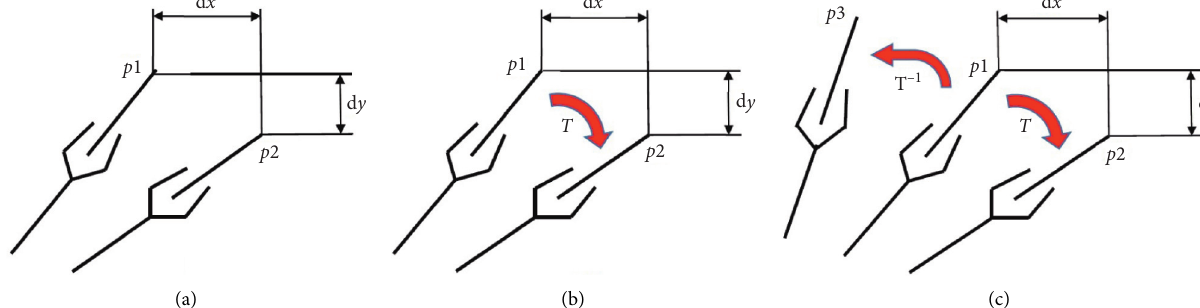
Figure 1: (a) Relationship between desired position P 1 and control deviation P 2 . (b) Transformation matric T from P 1 to P 2 . (c) Inversely convert T − 1 from P 1 to P 3 to initiate alternative